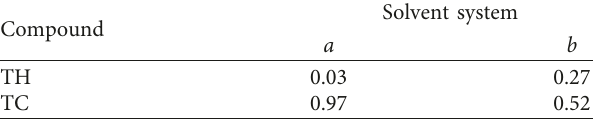
Table 1: R f values of thiamine HCl (TH) and thiochrome (TC). Compound